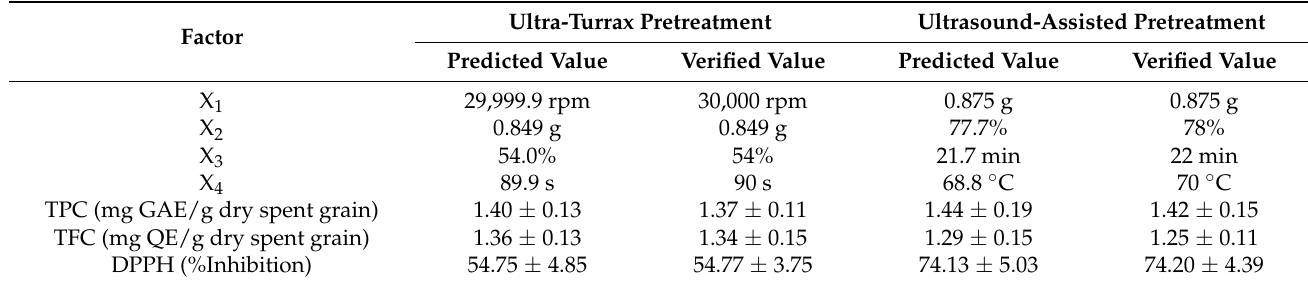
Table 3. Predicted and verified optimal sample